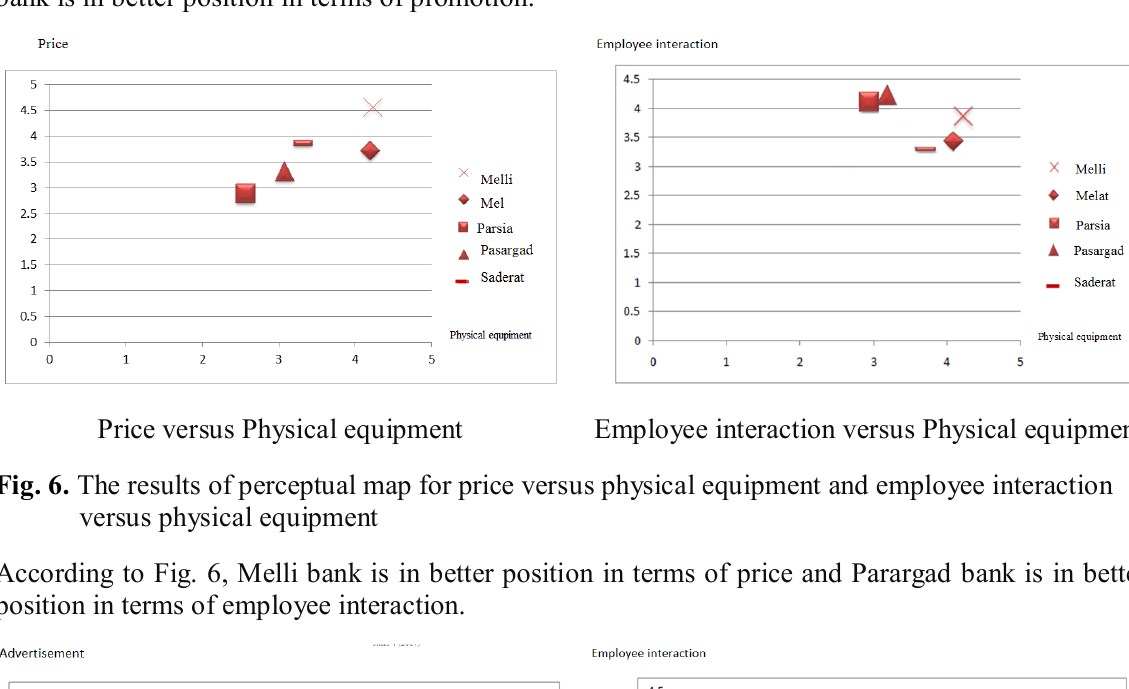
Fig. 5. The results of perceptual map for physical equipment versus security and price versus security According to Fig. 5, Pasargad bank is in better position in terms of employee interaction and Melat bank is in better position in terms of promotion.